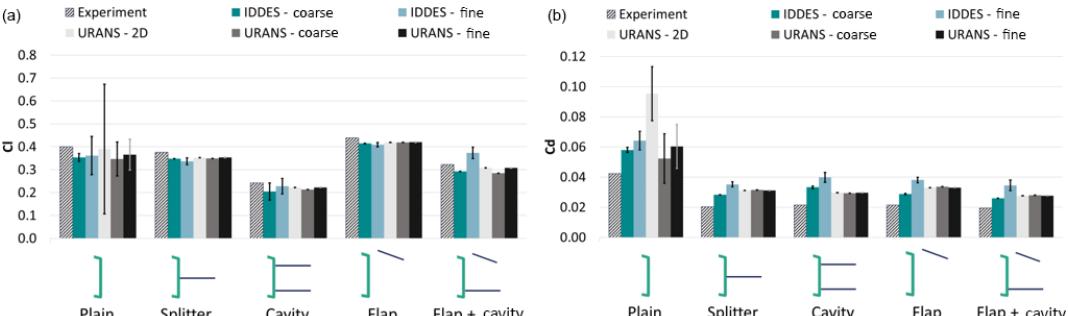
Figure 4. Lift (a) and drag coefficient (b) values for the plain airfoil and the airfoil with different TE devices: comparison between experi- ments, IDDES simulations and URANS simulations. Error bars in the numerical predictions are equal to the standard deviation of the force coefficient.